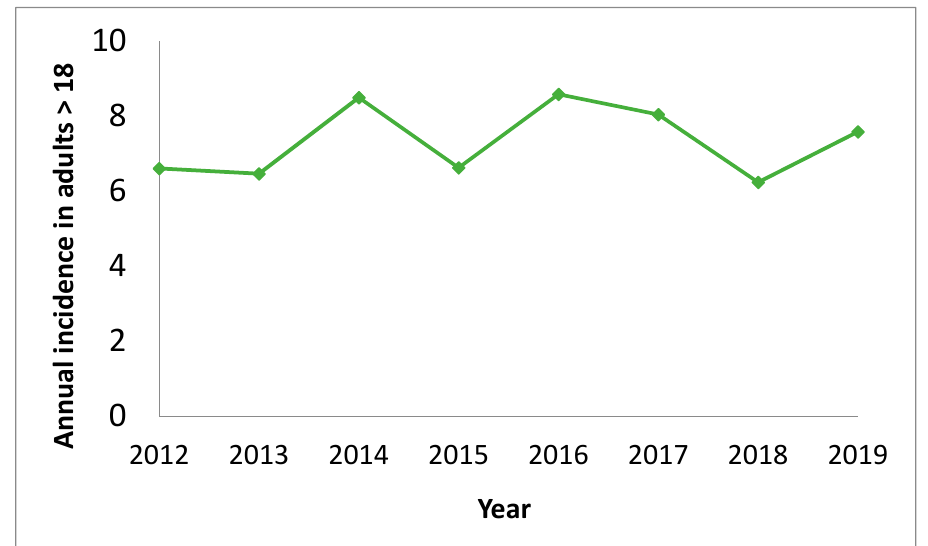
Figure 1. Annual incidence of invasive pneumococcal disease in adults aged 18 and older (cases per 100,000 population).